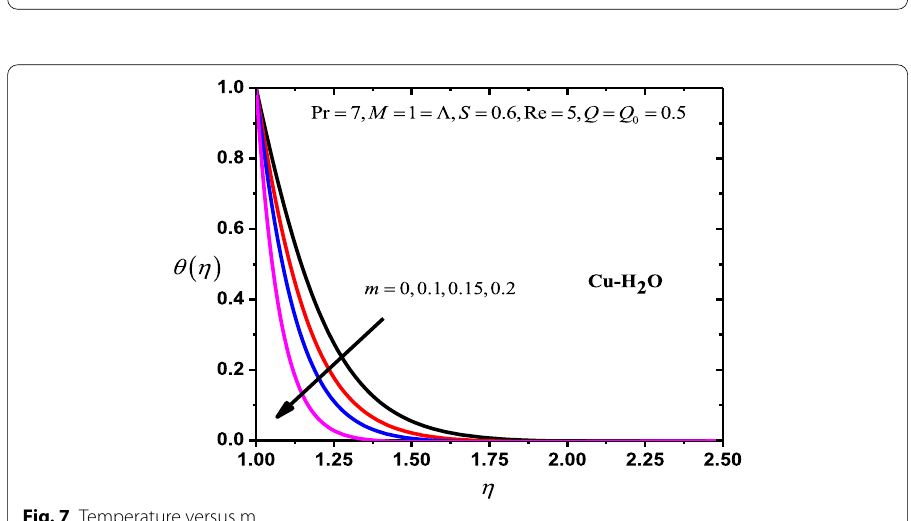
Fig. 7 Temperature versus m